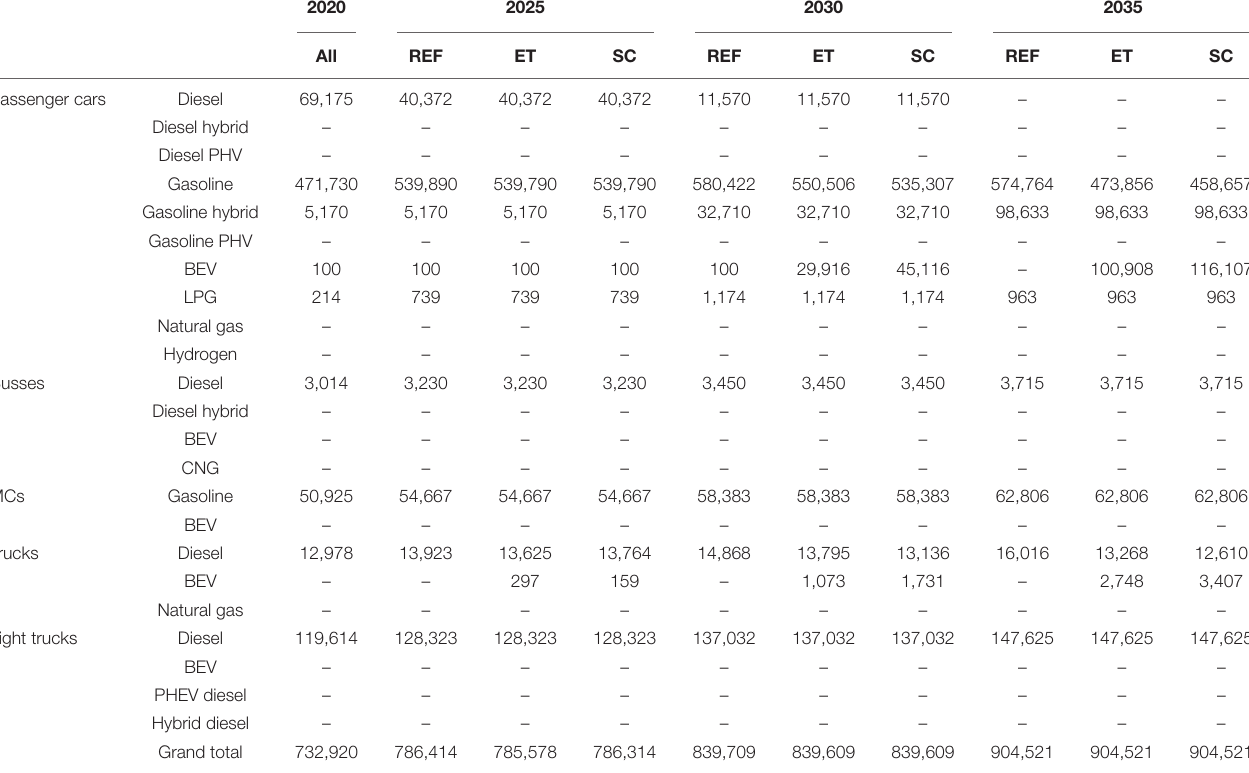
TABLE A5 | Scenario results on vehicle fleet projections in each